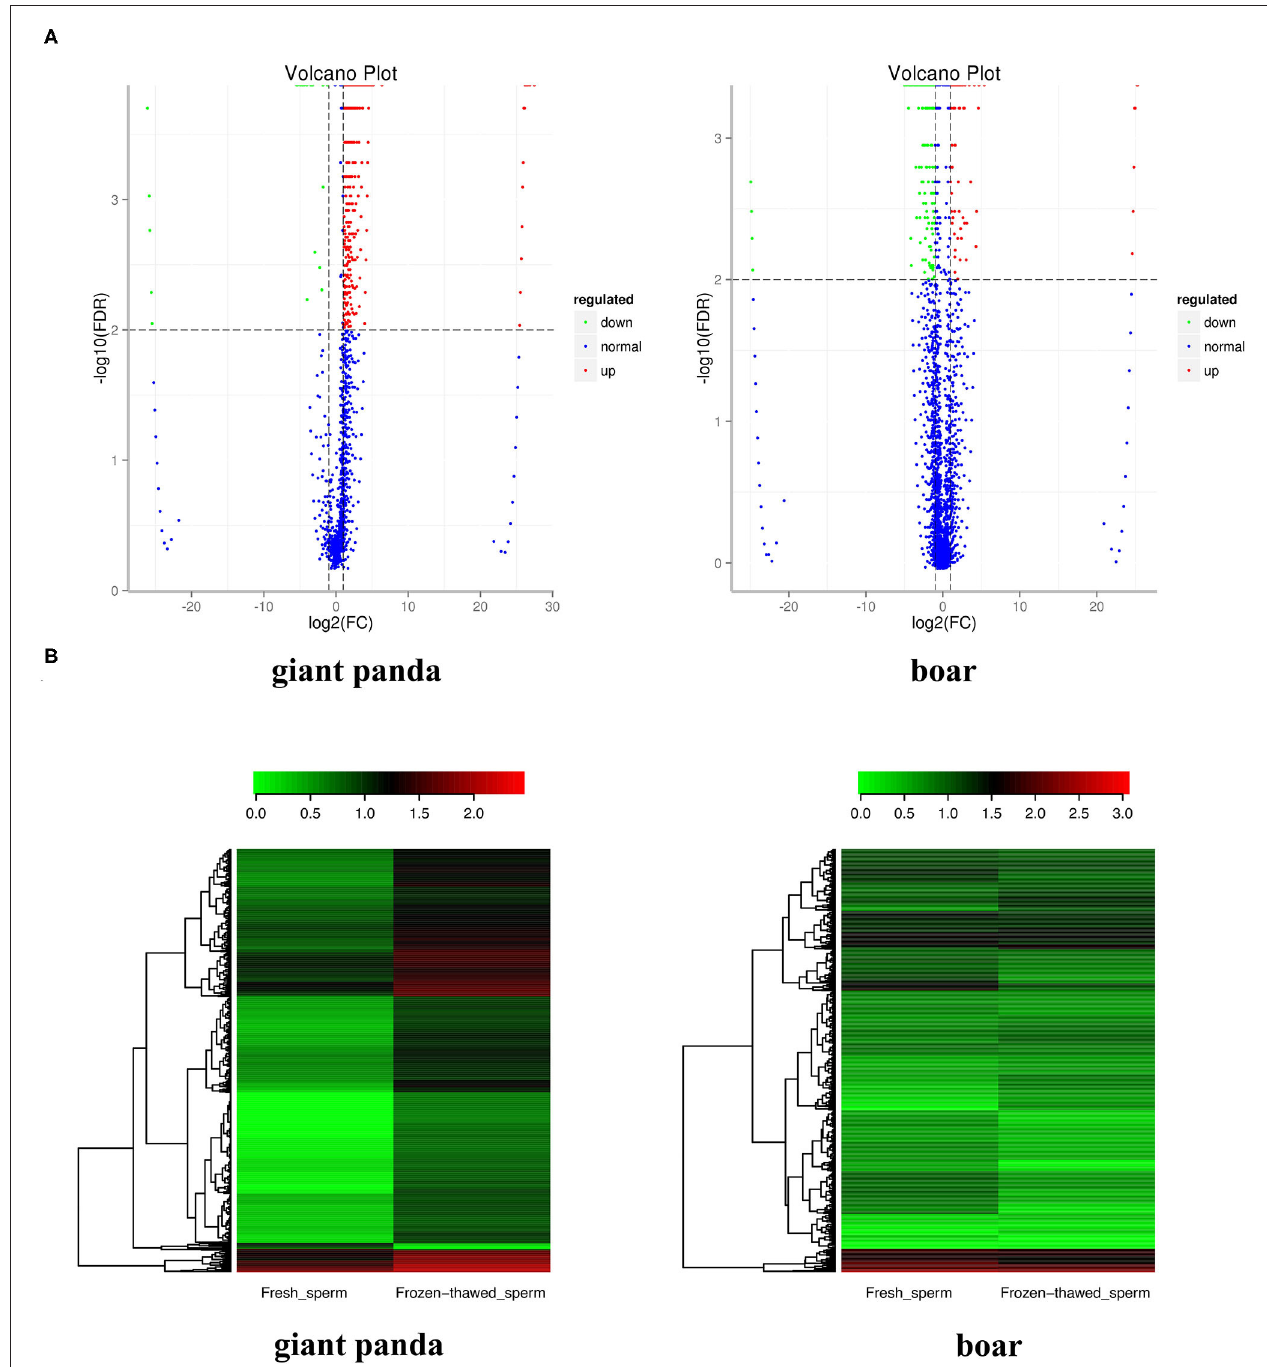
FIGURE 1 | Volcano plot and clustering analysis of differentially expressed PIWI-interacting RNAs (DE piRNAs) in fresh and frozen-thawed giant panda and boar sperm. (A) Volcano plot of DE piRNAs in fresh and frozen-thawed giant panda sperm. Blue dots represent normal expressed, green dots represent the downregulated, and red dots represent the upregulated piRNAs. (B) Heat maps of the cluster analysis of piRNAs. Red indicates high expression while green means low expression of